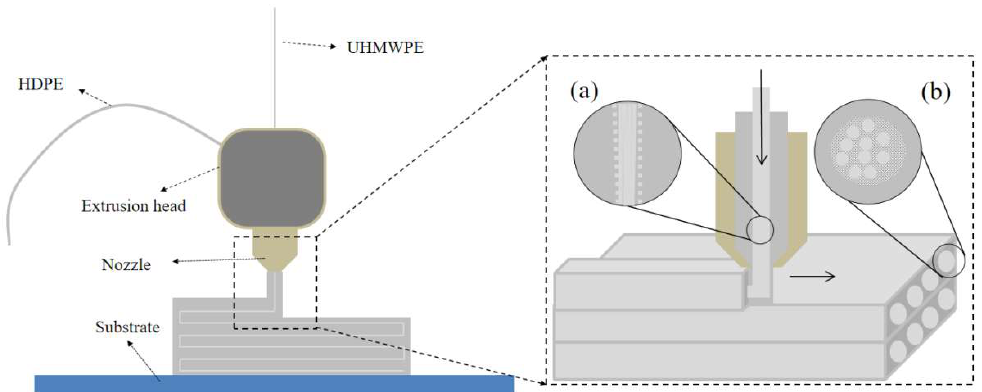
Figure 1. 3D printing scheme for CFSRCs with UHMWPE fibers on an HDPE matrix. ( a ) Partial surface melting of UHMWPE fibers. ( b ) Recrystallization of UHMWPE fibers.